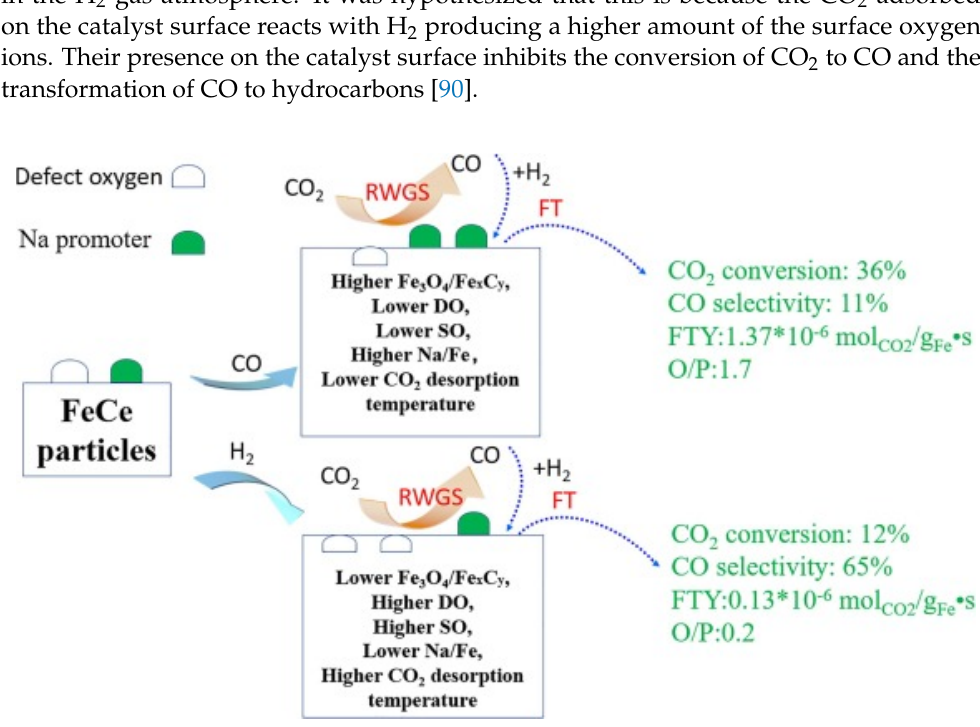
Figure 10. The effect of reducing gas atmosphere (CO 2 vs. H 2 ) on the CO 2 hydrogenation over 3% FeCeNa catalyst. Reproduced from Ref. [90] with copyright license from Elsevier (2021).